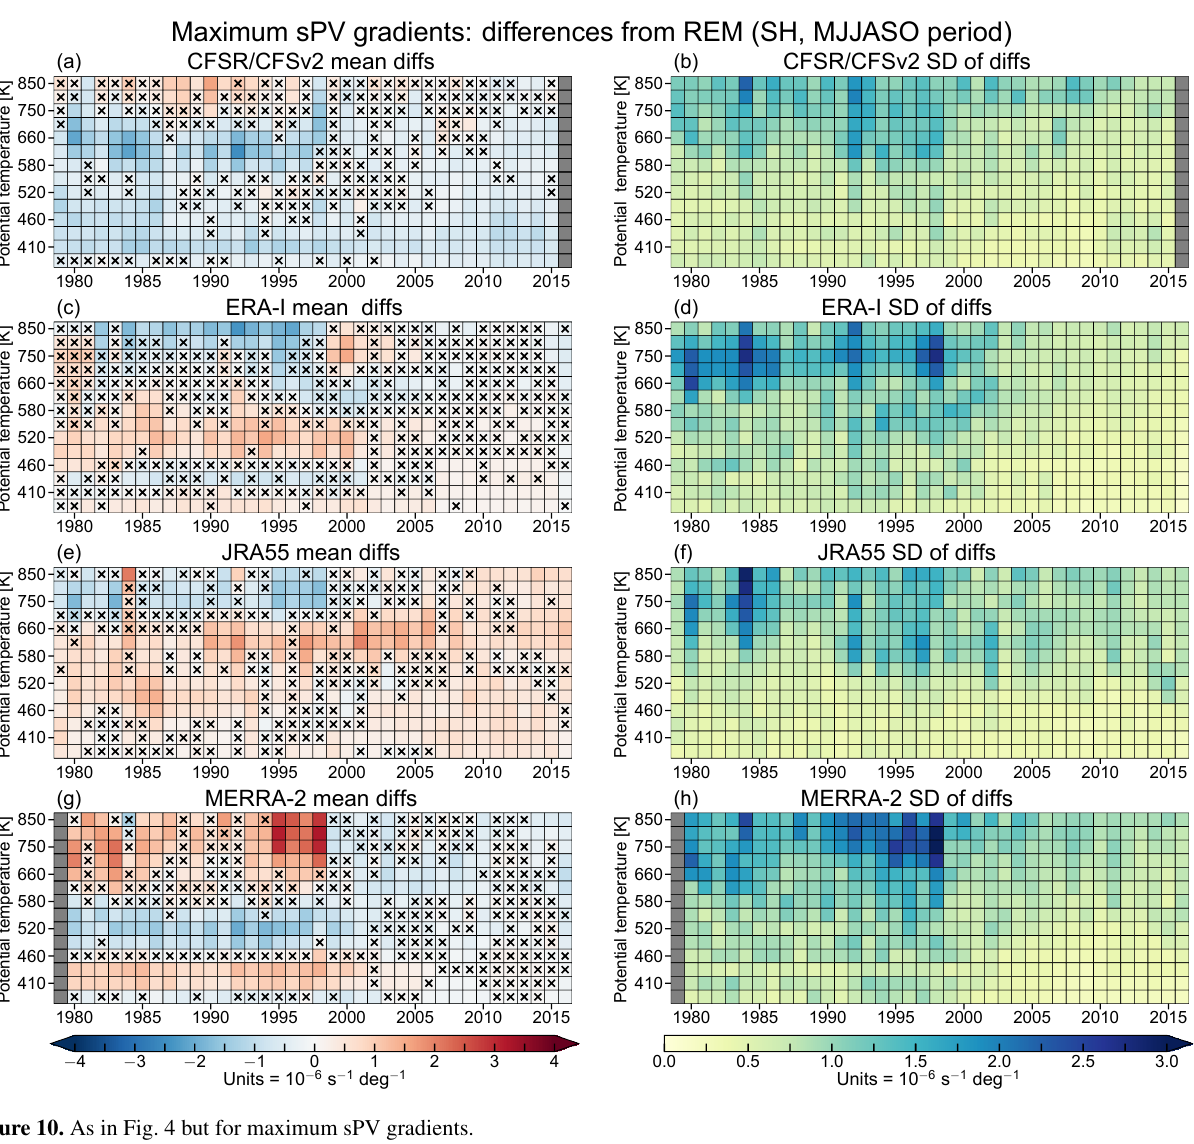
Figure 10. As in Fig. 4 but for maximum sPV